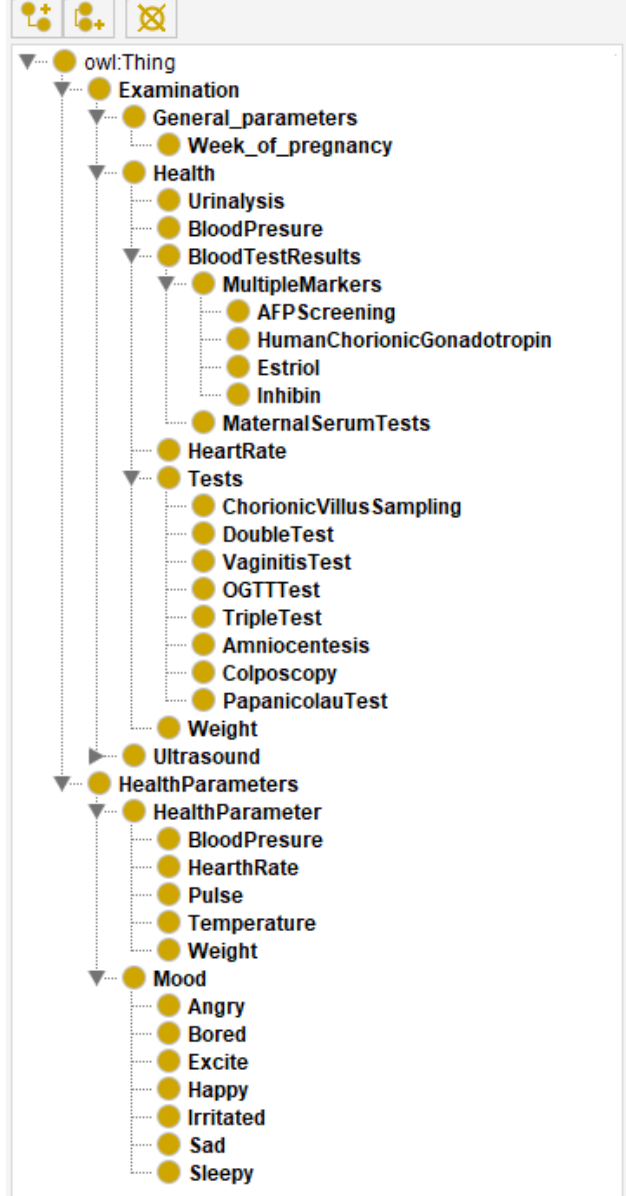
Figure 1. The ontology for pregnancy care.